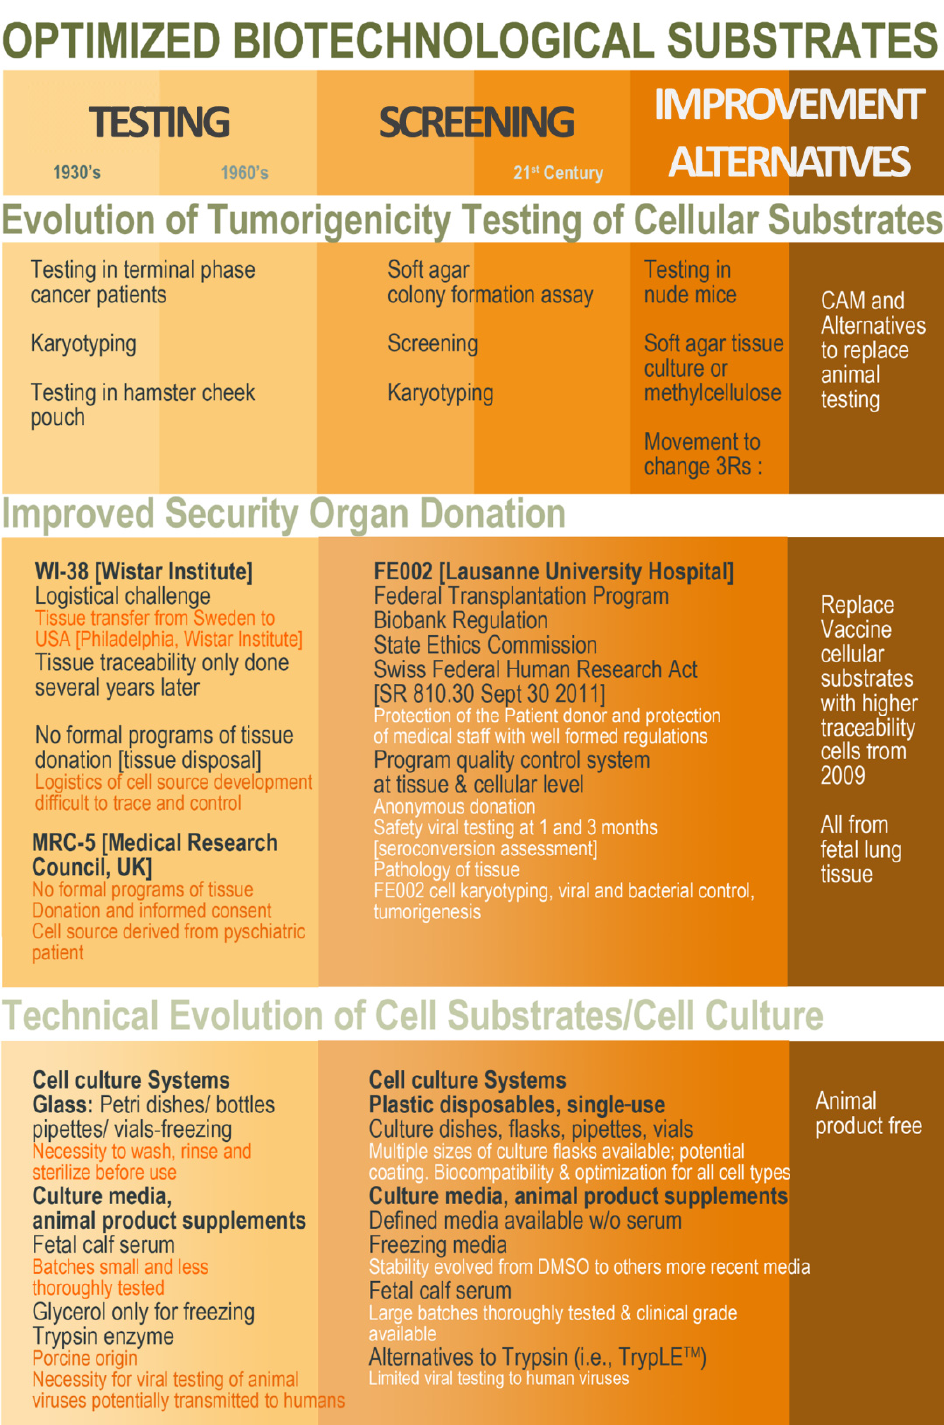
Figure 4. Schematic overview of the ethical, legal, and technical parameter evolution around the establishment of cell sources to be characterized and qualified for use as vaccine production substrates. Overall, hindsight and experience gathered from historic industrial practice may be conjugated with modern regulatory and technical workflows in order to develop optimized (i.e., safe, sustainable, and efficient) biotechnological substrates obtained in modern regulatory settings and methodological workflows. CAM, chorioallantoic membrane; DMSO, dimethyl sulfoxide.